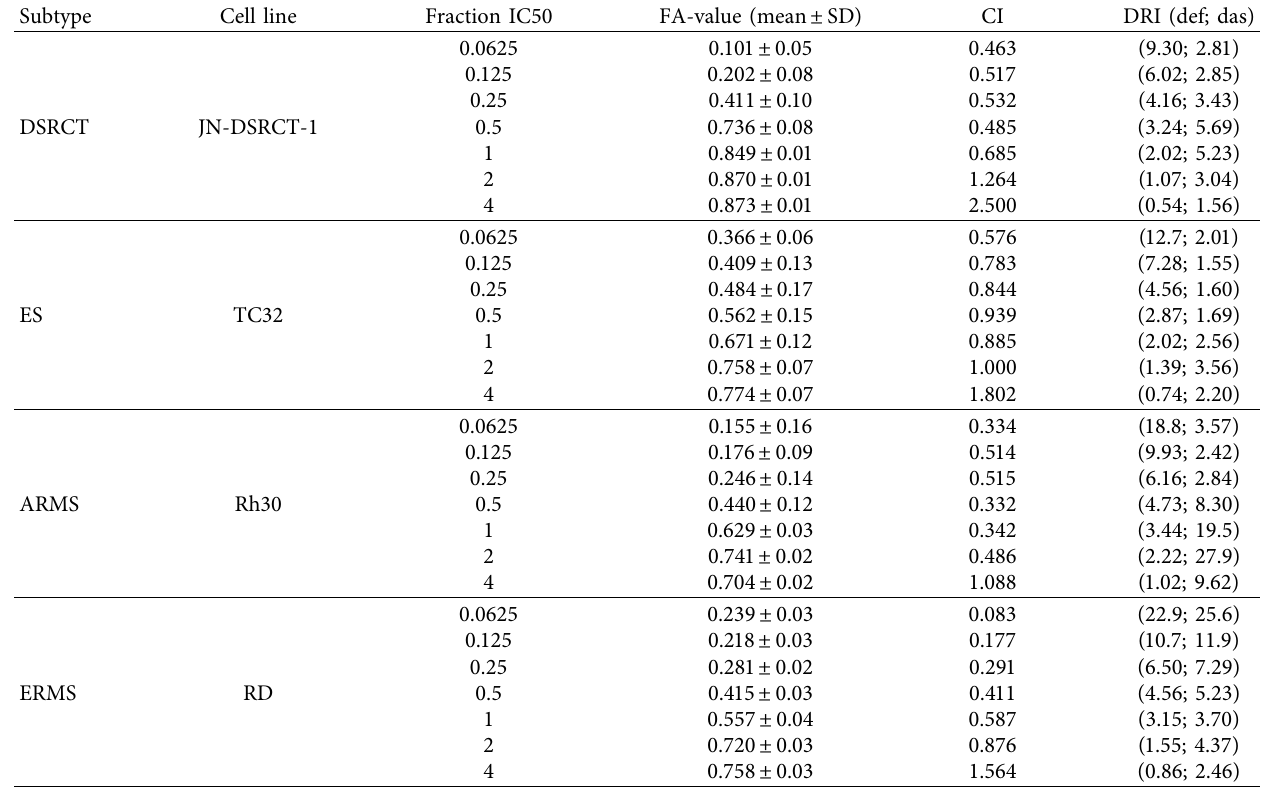
Table 4: FA, CI, and DRI values for defactinib and dasatinib combination treatment in DSRCT, ES, ARMS, and ERMS cell lines.